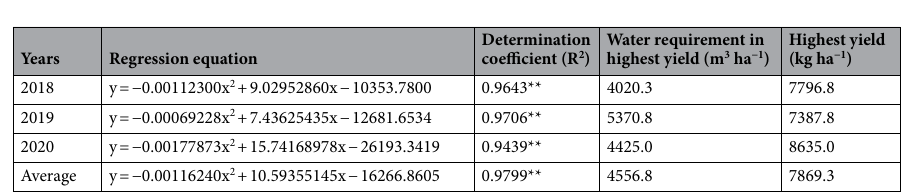
Table 6. Regression equations of both rice grain yield under dry-farming and water requirement (2018–2020). *, **Means significant at 5% and 1%,